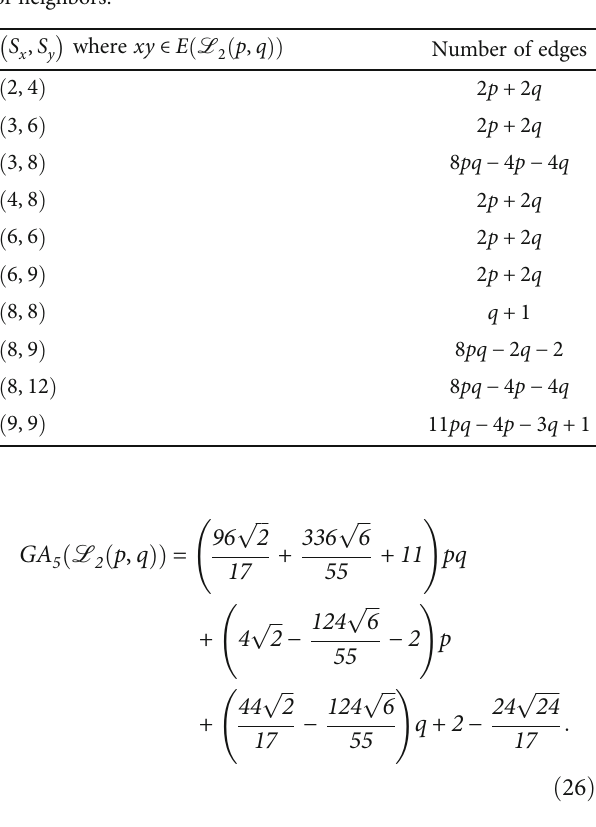
p , q Þ based on the sum of degree 2 ð